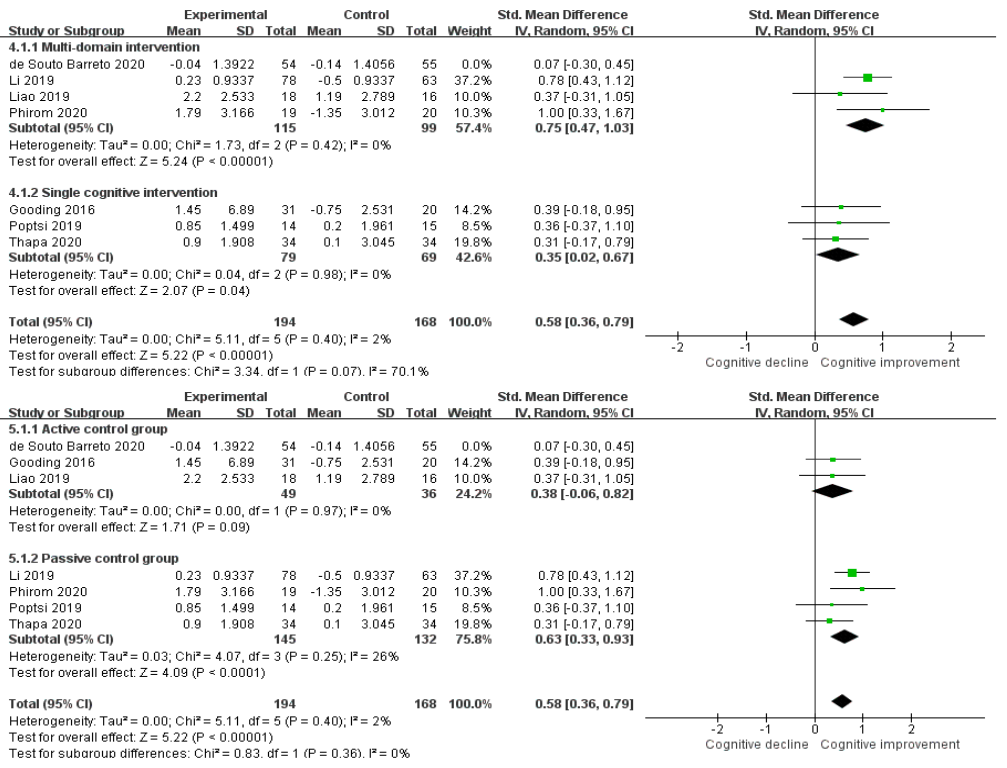
Figure 5. Forest plots of subgroup analysis.